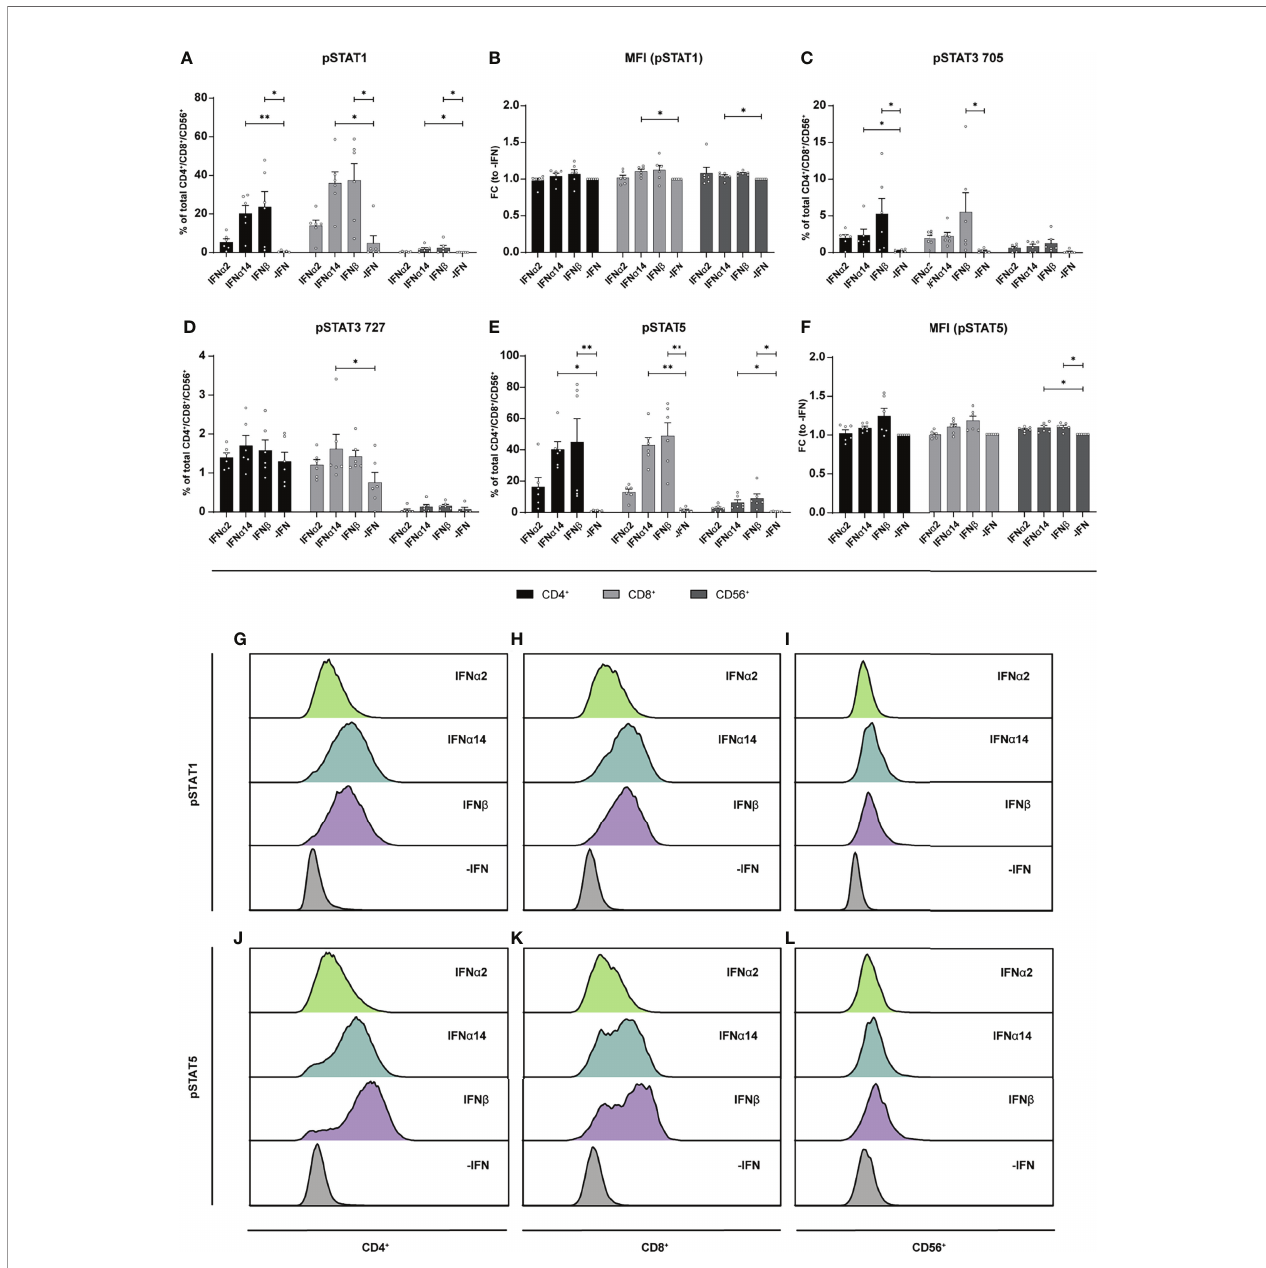
FIGURE 7 | Phosphorylation of STAT molecules after IFN stimulation in PBMCs. PBMCs from healthy donorswere stimulated with 2000 U/ml IFN a 2, IFN a 14, IFN b , or withoutIFN (-IFN) inpresence of the surfacemarkers anti-CD3, anti-CD4, anti-CD8, anti-CD56, and the viability marker FVD.Cellswere then fi xatedand permeabilized for phosphostaining with anti-STAT1 pTyr702, anti-STAT5 pTyr694, anti-STAT3 pTyr705, and anti-STAT3 pSer727. (A) Frequencies of phosphorylated STAT1, (B) mean donor-speci fi c fold changes of MFI (pSTAT1) (C) frequencies of phosphorylated STAT3 pTyr705, (D) STAT3 pSer727, (E) STAT5, and (F) mean donor-speci fi c fold changes of MFI (pSTAT5) on CD4 + , CD8 + T, andNKcells. Mean values ± SEM are shown for n=6. Statistical analyses between the treated groups within a cellpopulation were done byusing Friedman test andDunn ’ s multiplecomparisontest. **,P < 0.01; *, P < 0.05. (G) Representative histogramsofphosphorylatedSTAT1 expression by unstimulated or IFN-stimulated CD4 + , (H) CD8 + T cells, and (I) NK cells as well as (J) phosphorylatedSTAT5 expression by CD4 + , (K) CD8 + T cells, and (L) NK